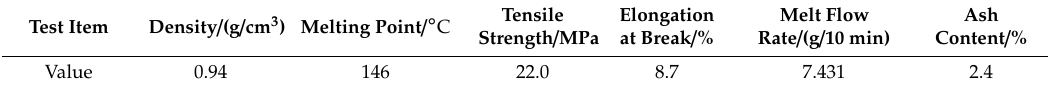
Table 8. Main Features of Granular Polymer Durable additive (GPDa).